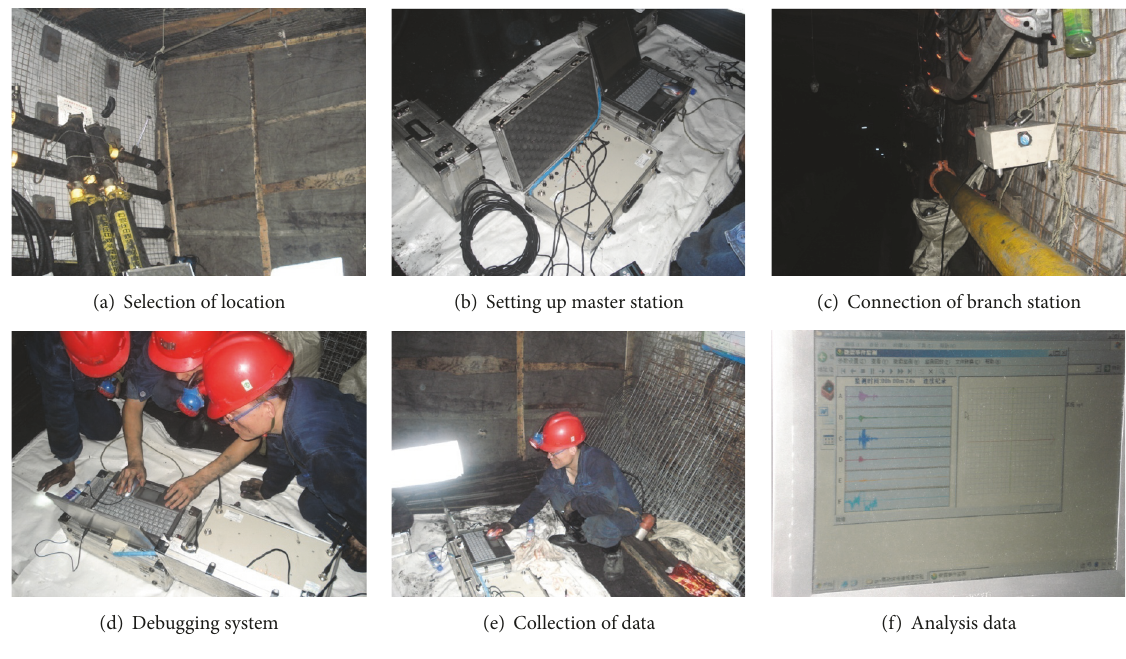
Figure 11: Experimental procedure of Test